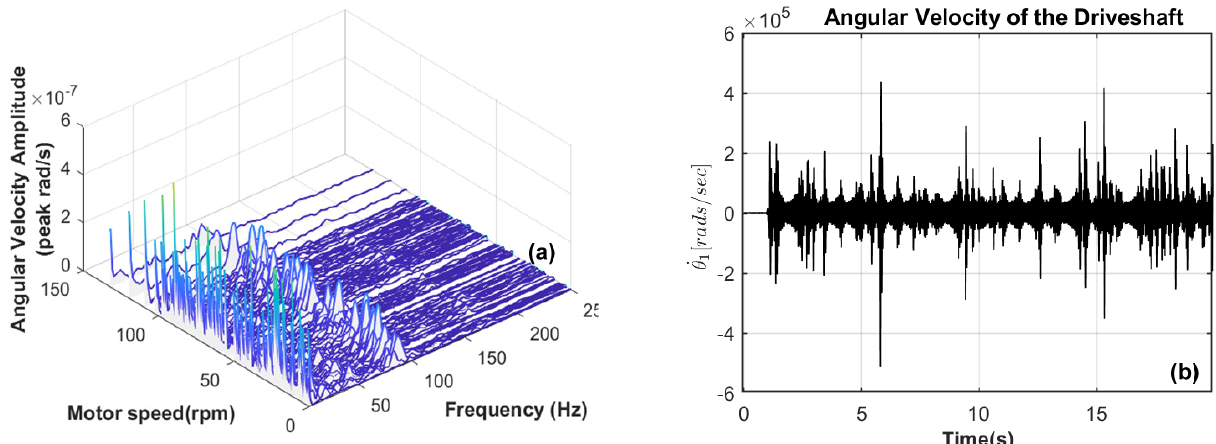
Figure 10 ‐ The 3 ‐ D driveshaft frequency spectrum of angular velocity during acceleration. ( a ) motor speed variation frequency ( b ) angular velocity vibration of the unbalanced and rubbing driveshaft.